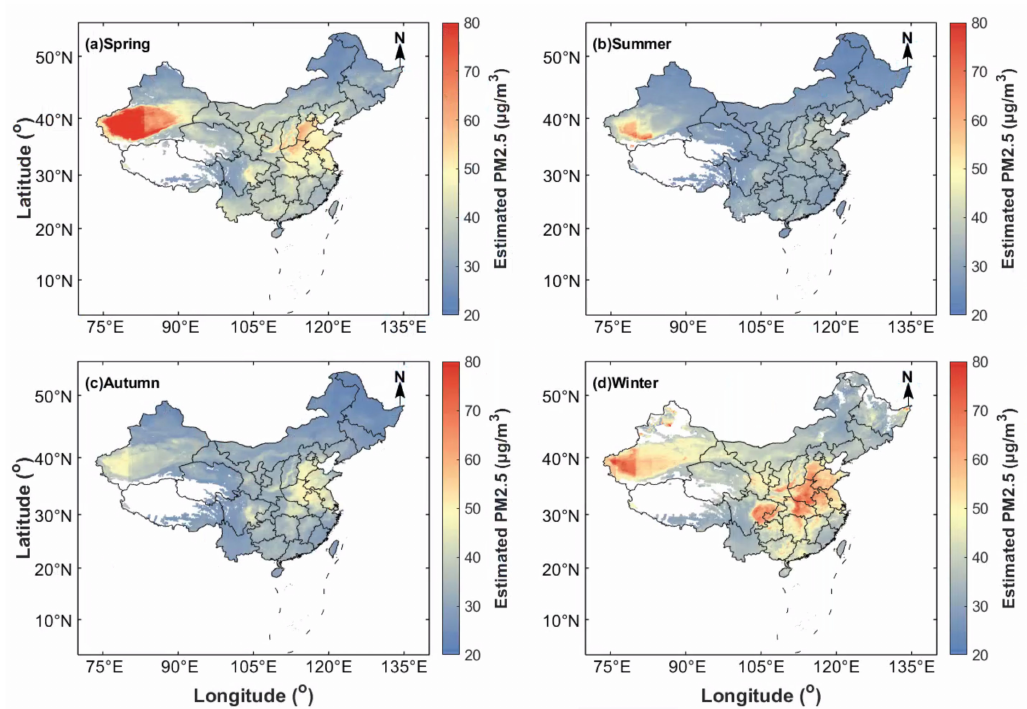
Figure 8. Spatial distribution of seasonal PM 2.5 concentrations estimated by the STBT model: ( a ) Spring, ( b ) Summer, ( c ) Autumn, and ( d )